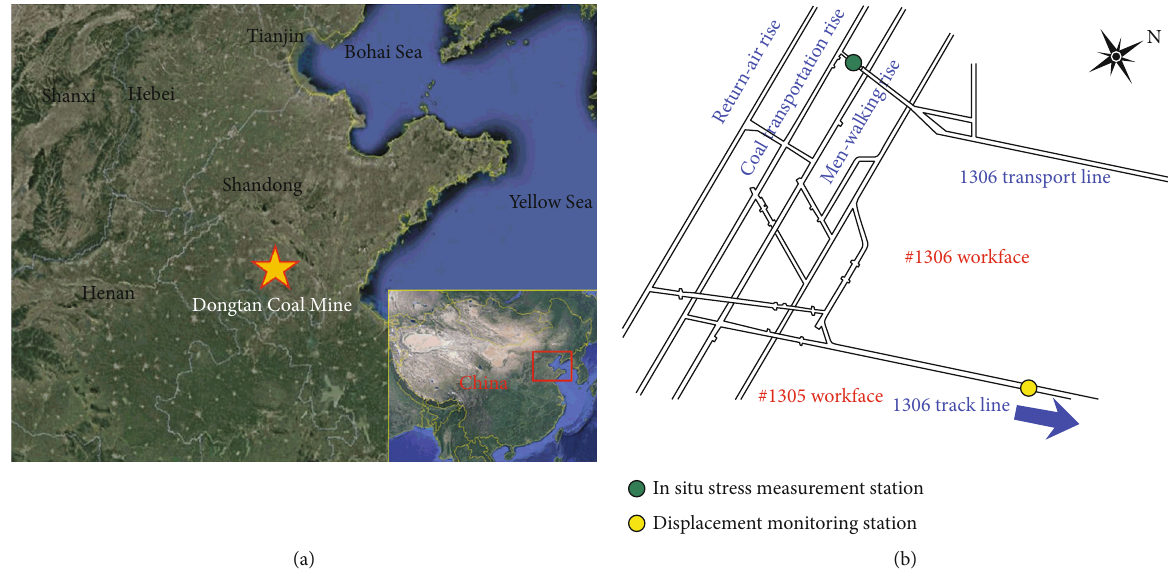
Figure 1: (a) Location of the Dongtan Coal Mine, Shandong, China. (b) Plane view of working face arrangement.